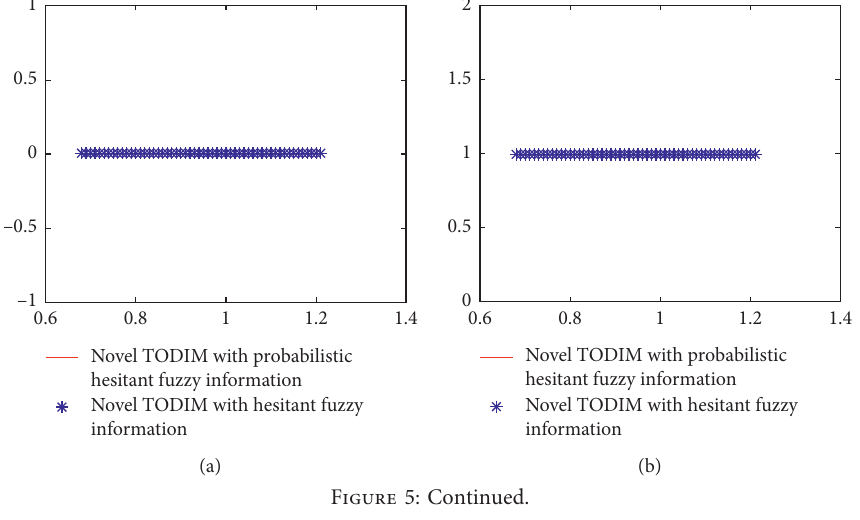
Figure 4: Sensitivity analysis of the novel TODIM by changing λ . 1 . 25 ≤ λ ≤ 2 . 25, α � β � 0 . 88, δ � 0 . 69, and c � 0 . 61. (a) A (d) A 4